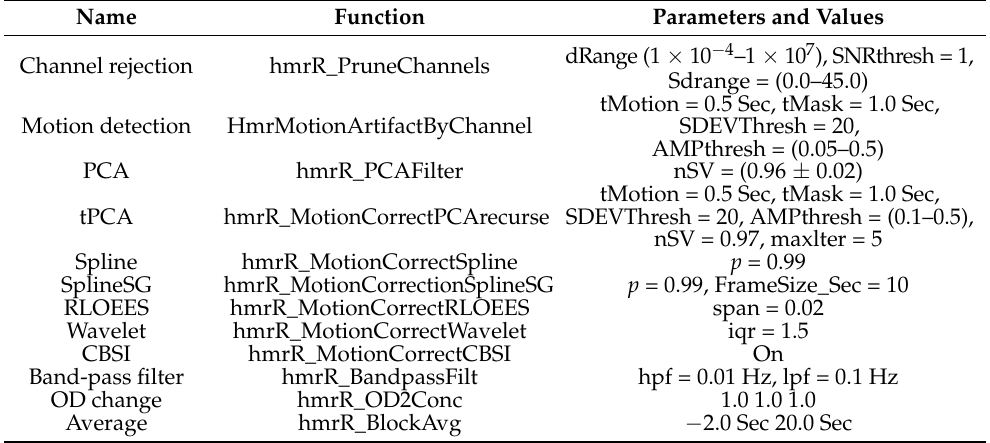
Table 1. User parameter settings for every HOMER3 function used in the processing